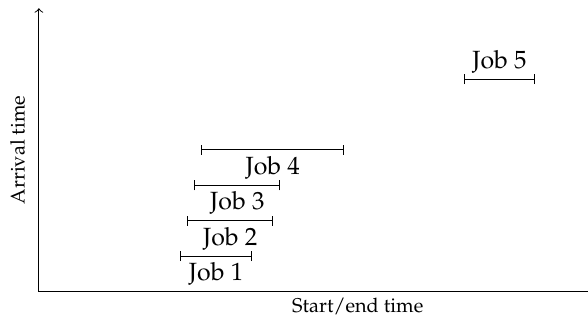
Figure 2. Representation of the instance presented in Table